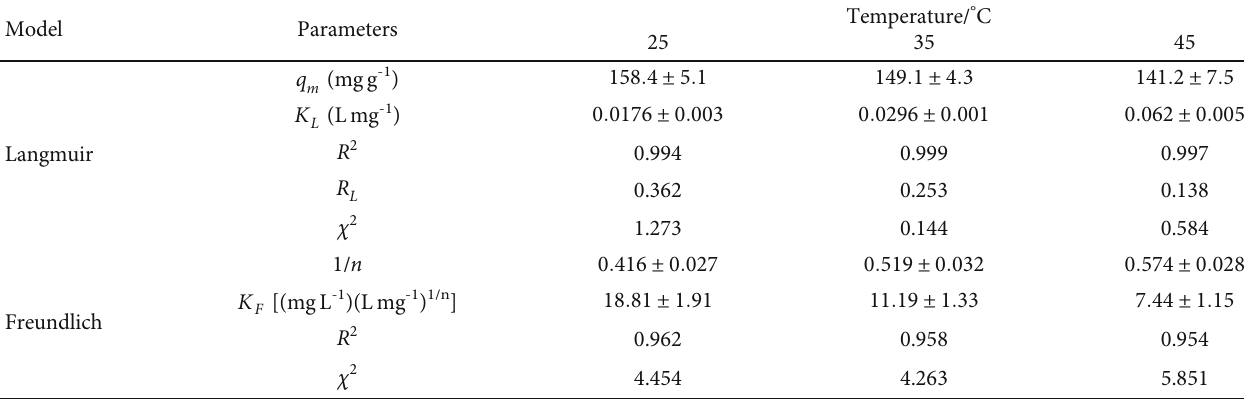
Table 4: The data of isotherm model parameters obtained on adsorption of BPA by AgNPs-SB- β CD.